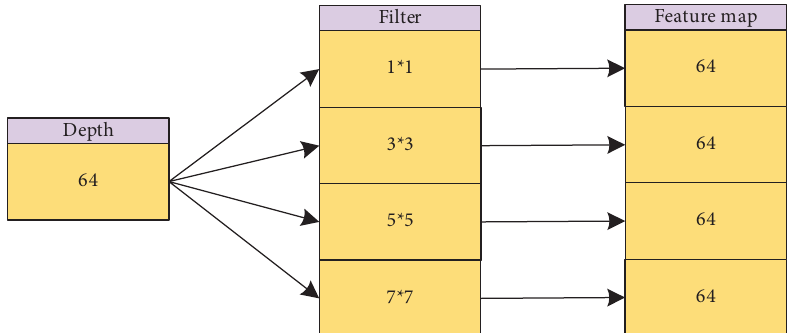
Figure 2: Multiscale convolution kernel operation.